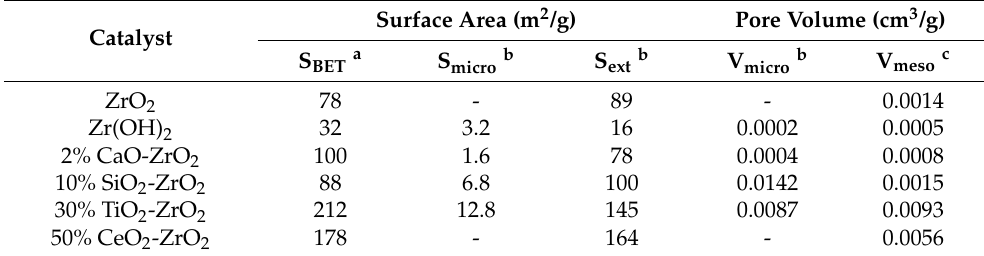
Table 4. Catalyst particle size and BET surface area after the reaction.